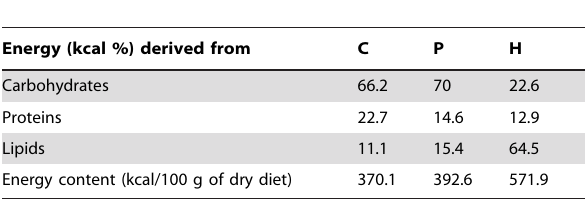
Table 1. Energy content of the commercial chow diet (C) and the semi-purified highly palatable (P) and high-fat (H) diets.